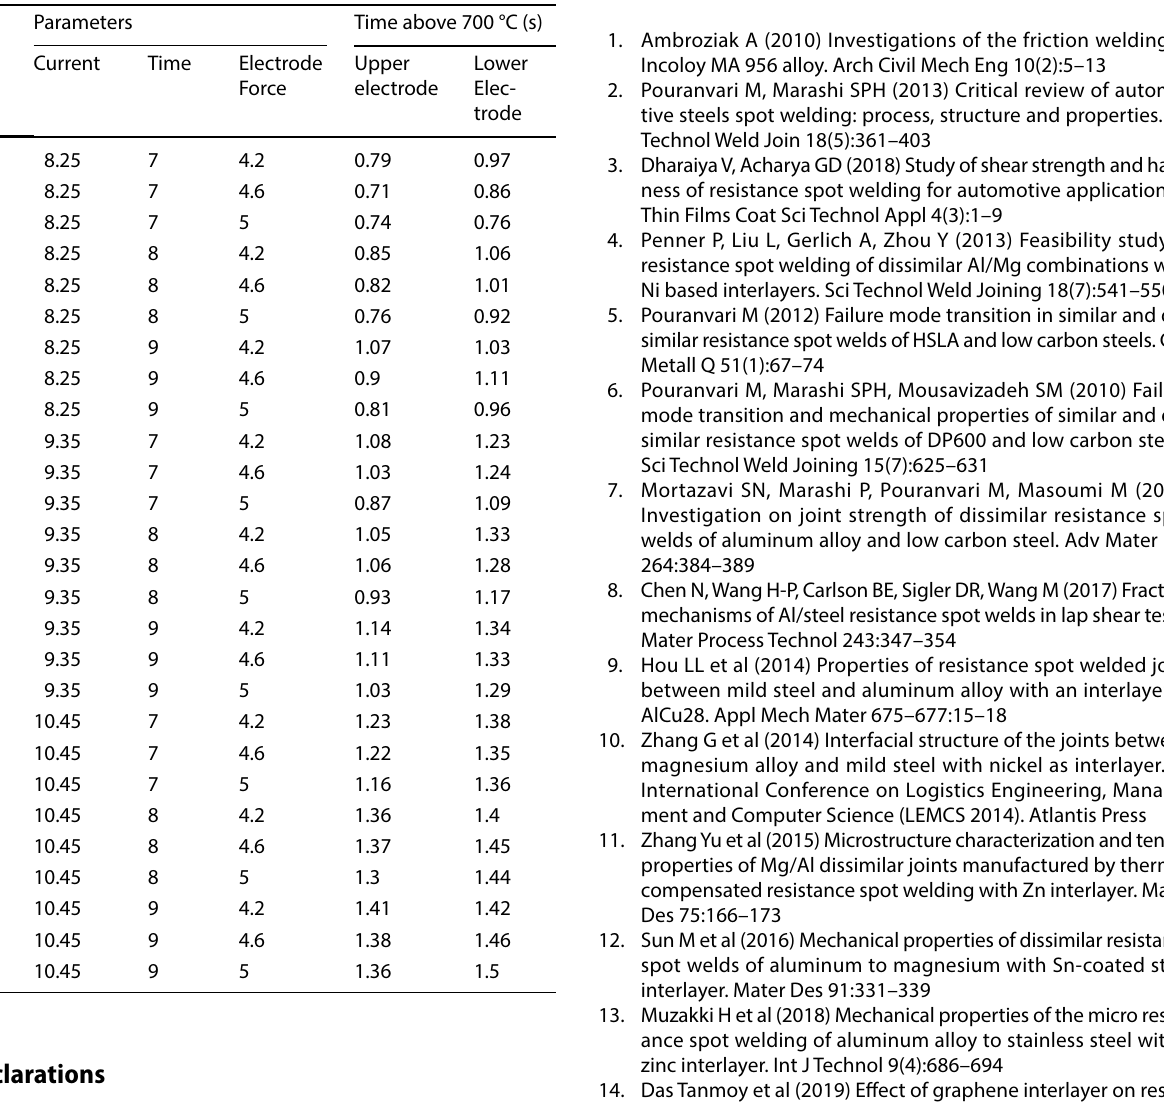
Table 8 Time for electrodes prone to